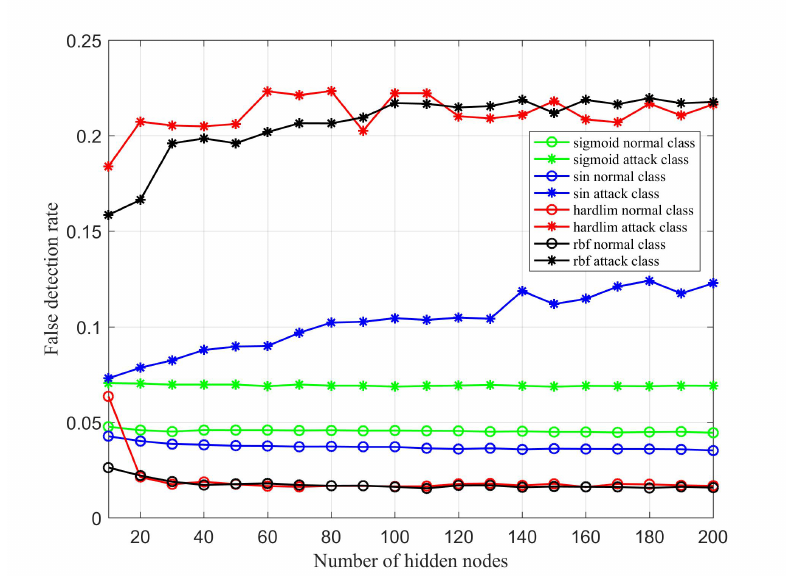
Figure 9. False detection rate of ILECA under different activation functions.